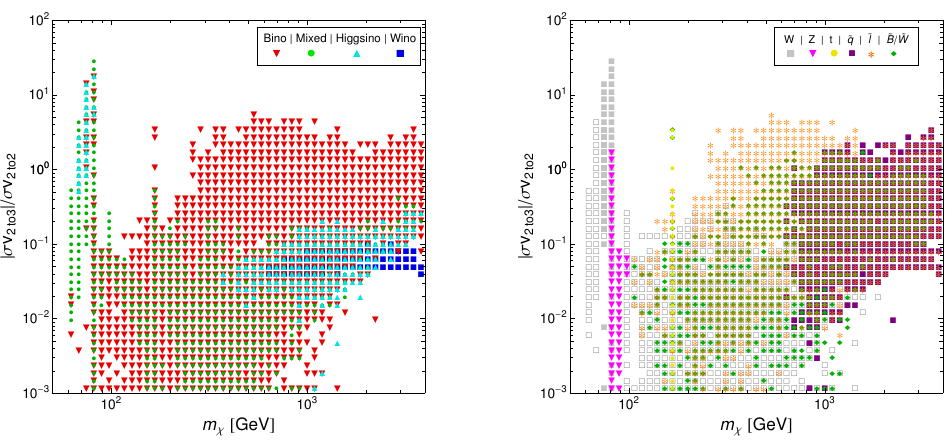
Figure 6 . Left panel : ratio between the (NWA subtracted) three-body and total two-body cross section for the MSSM models de(cid:12)ned in section 5.1, as a function of the lightest neutralino mass 2 > 0 : 8) in red, \Wino" m (cid:31) . Di(cid:11)erent neutralino compositions are indicated as \Bino" ( N 11 j j 2 > 0 : 8) in blue, \Higgsino" ( 2 + 2 > 0 : 8) in cyan, and \mixed" (otherwise) in ( N 12 N 13 N 14 j j j j j j green. Right panel : same, but now broken down to models that are either (a) close to a threshold X = W; Z; t (with 4 (cid:0) X < m (cid:31) m X < (cid:0) X , where (cid:0) X is the total width of X ) or (b) with a (cid:0) (cid:0) degenerate sfermion ~ f in the mass spectrum ( m (cid:31) =m ~ > 0 : 9) or (c) Bino-like neutralinos with f